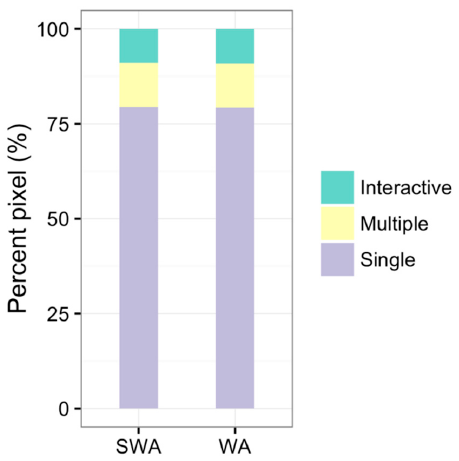
Figure D3. Percent pixel with the mode of the lowest Akaike’s Information Criterion (AIC) as a function of study region (South West Africa, SWA, and West Africa, WA). “Single” = model with only rainfall of concurrent year as explanatory variable, “Multiple” = model with rainfall of concurrent year and previous year as additive variables and “Interactive” = model with an added interaction term of the “Multiple” model.